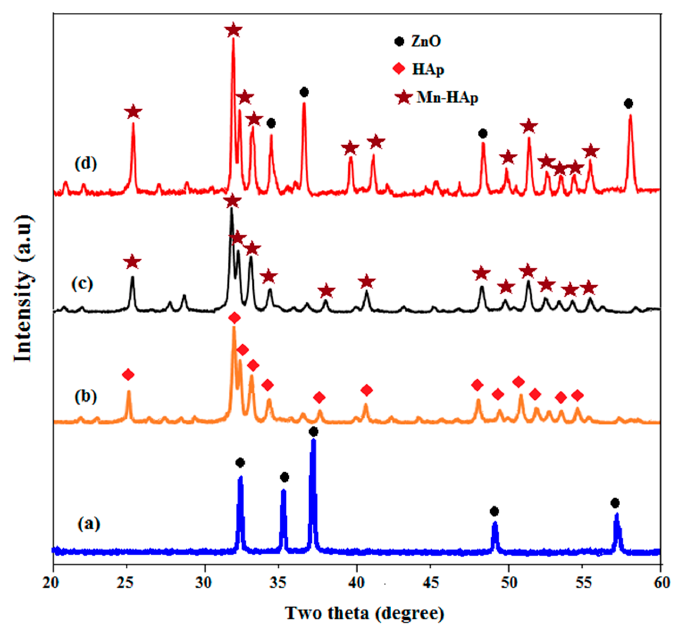
Figure 3. X-ray diffraction (XRD) patterns of ( a ) ZnO, ( b ) HAp, ( c ) Mn-HAp, and ( d ) Mn-HAp/ZnO bilayer coating on 316L SS.